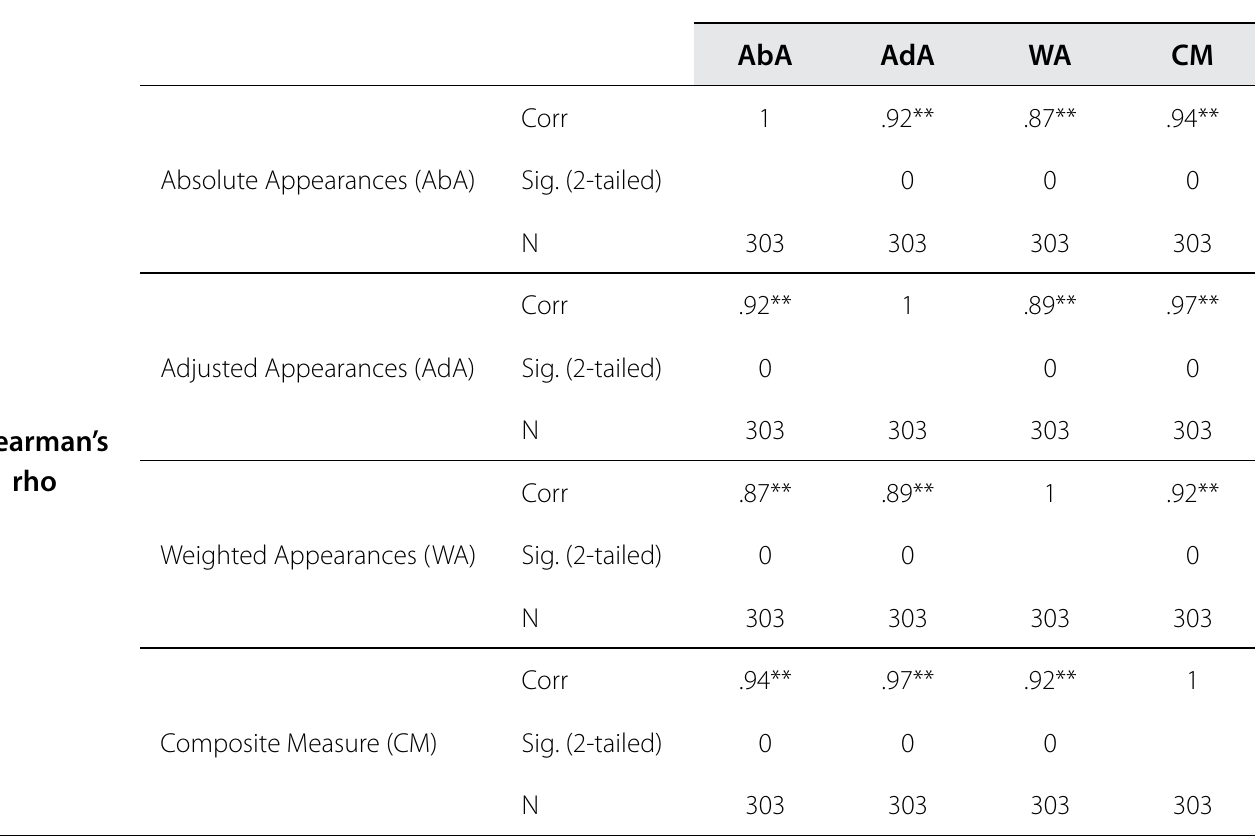
Table 12. Spearman Rank Correlation of Institution Impact